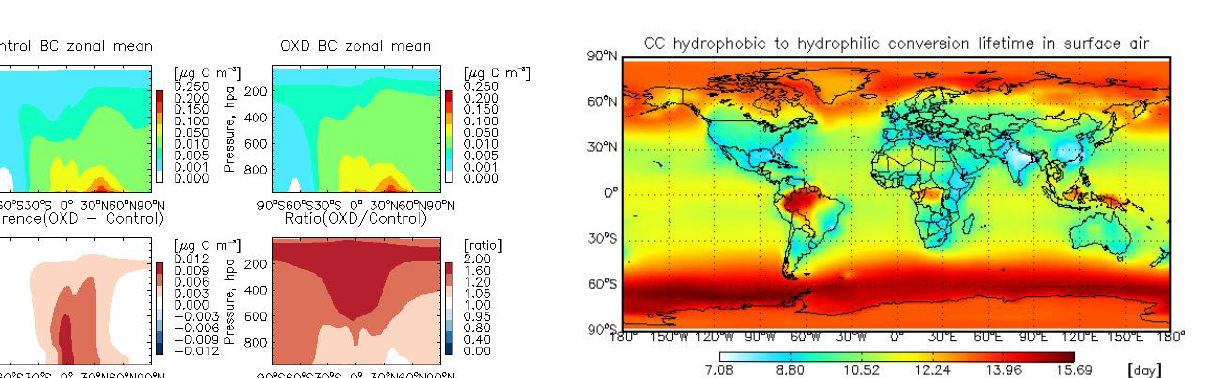
Fig. 3b. Same as Fig. 3a but for OC.